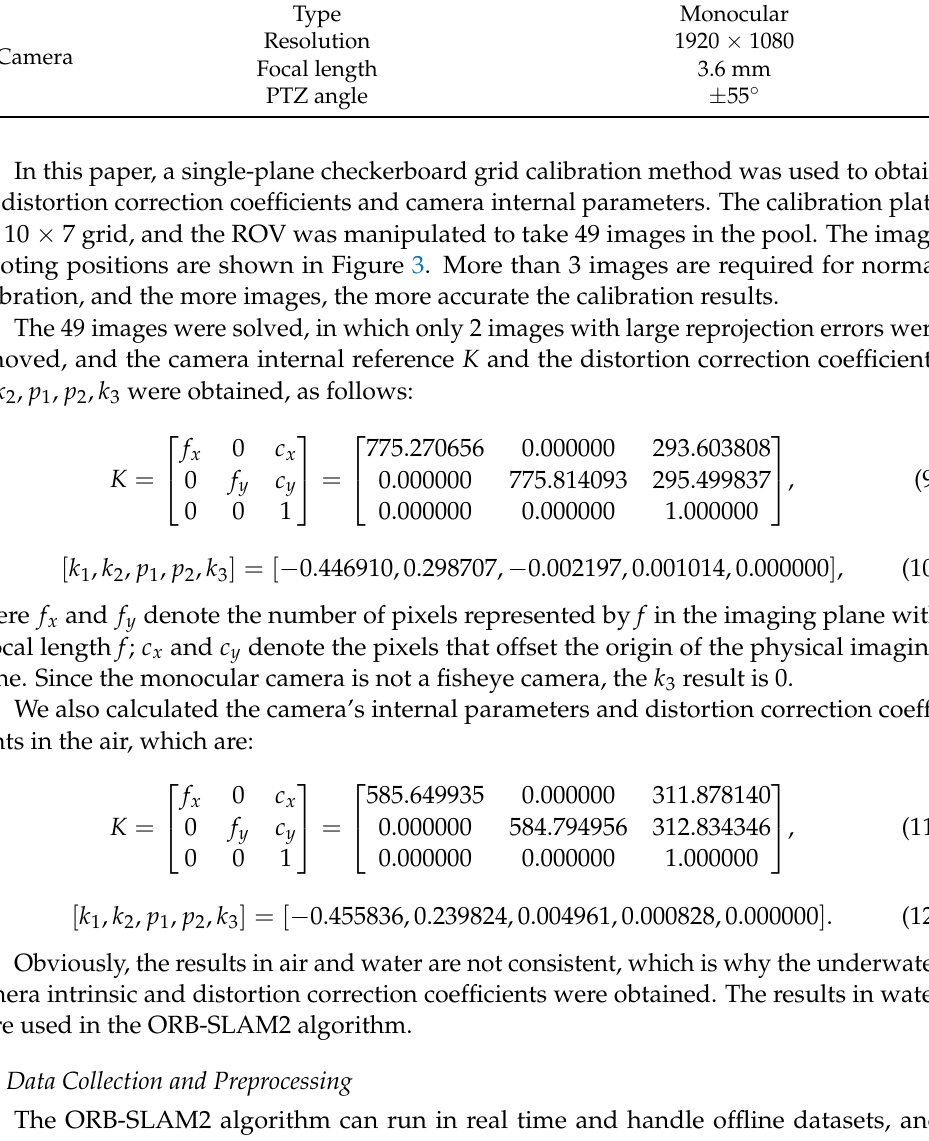
Table 1. ROV and monocular camera parameters table. Item Parameter Size 416 × 355 × 210 mm Working depth 75 m ROV Weight in air 2.8 kg Speed 3 kn Type Monocular Resolution 1920 × 1080 Camera Focal length PTZ angle ± 55